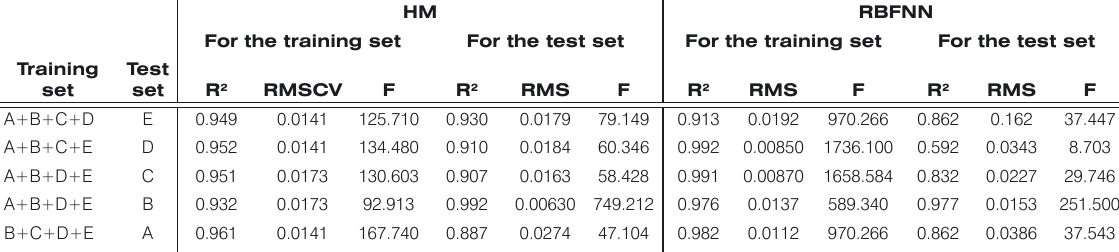
Table 3. Validation of correlations for the HM and RBFNN models HM RBFNN For the training set For the test set For the training